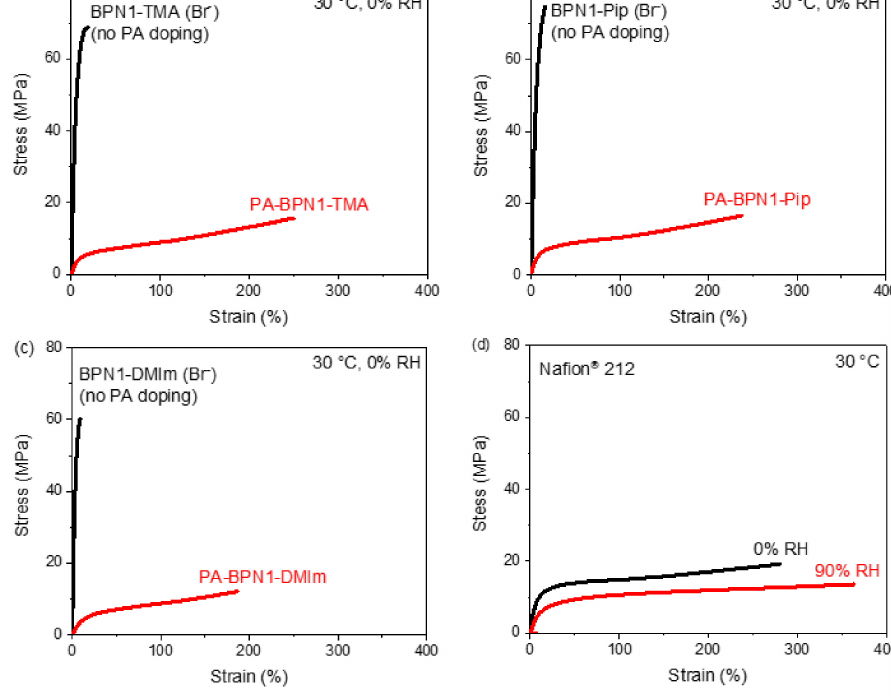
Figure 7. Stress-strain curves of ( a ) BPN1-TMA; ( b ) BPN1-Pip; ( c ) BPN1-DMIm; and ( d ) Nafion ®